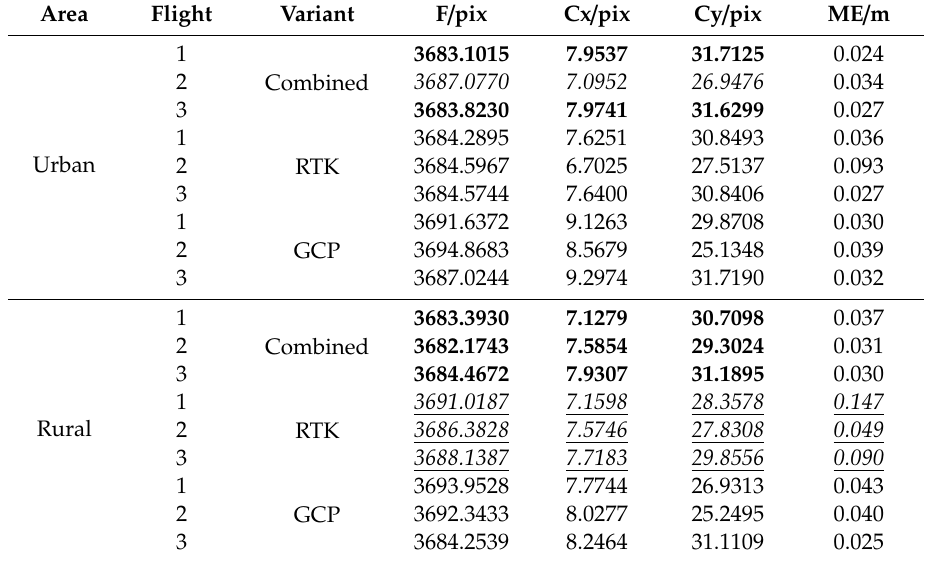
Table 11. Interior orientation parameters determined for the individual calculation variants and flights (ME–Mean error in the vertical